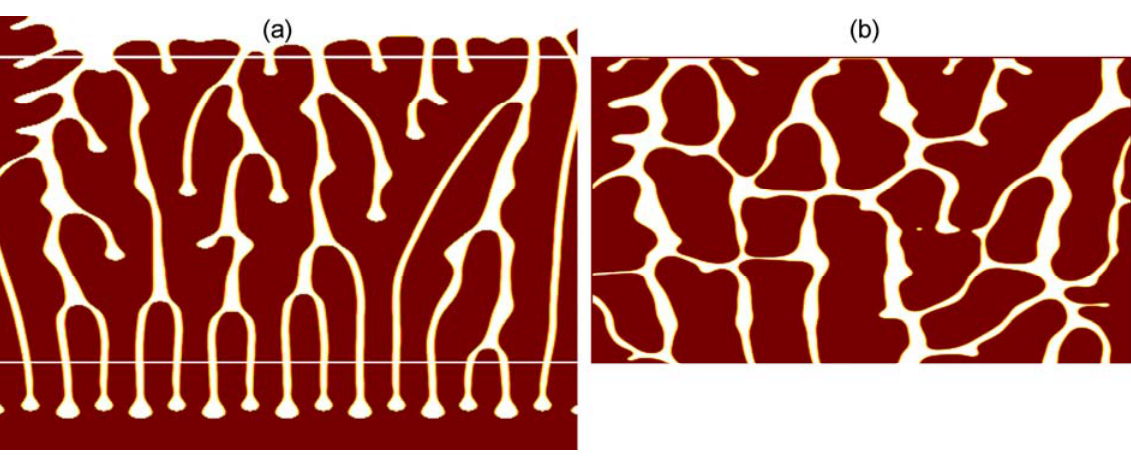
Figure 4. ( a ) Phase-field simulation illustrating how remelting of a dendritic seaweed structure ( a ) can give rise ( b ) to a grain refined